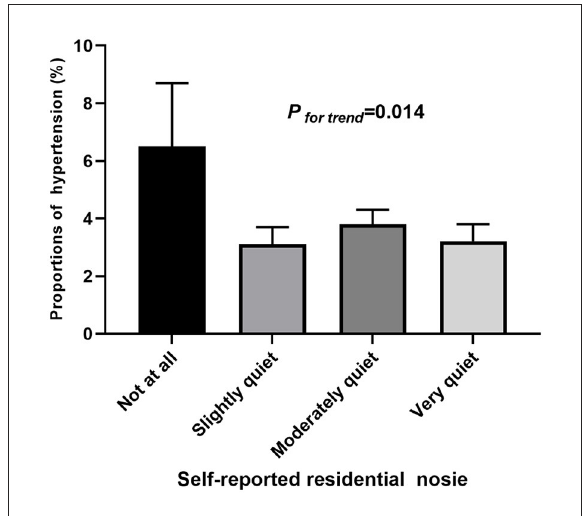
FIGURE2 Proportions of hypertension by self-reported residential noise